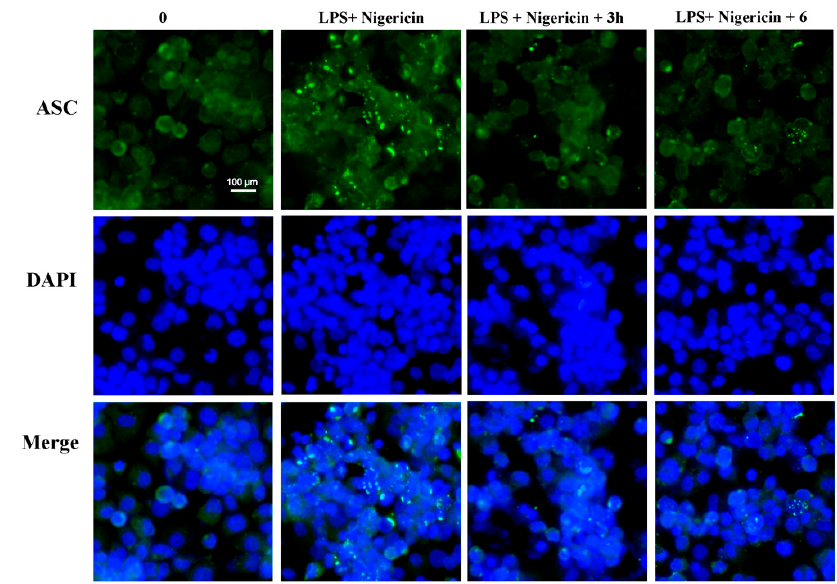
Figure 5. PMA-differentiated THP-1 cells were stimulated with LPS (5 µ g/mL)/NIG (20 µ M) in the absence or presence of 5 µ M 3h or 6 . Arrowhead marks the ASC pyroptosome stained by the ASC antibody.